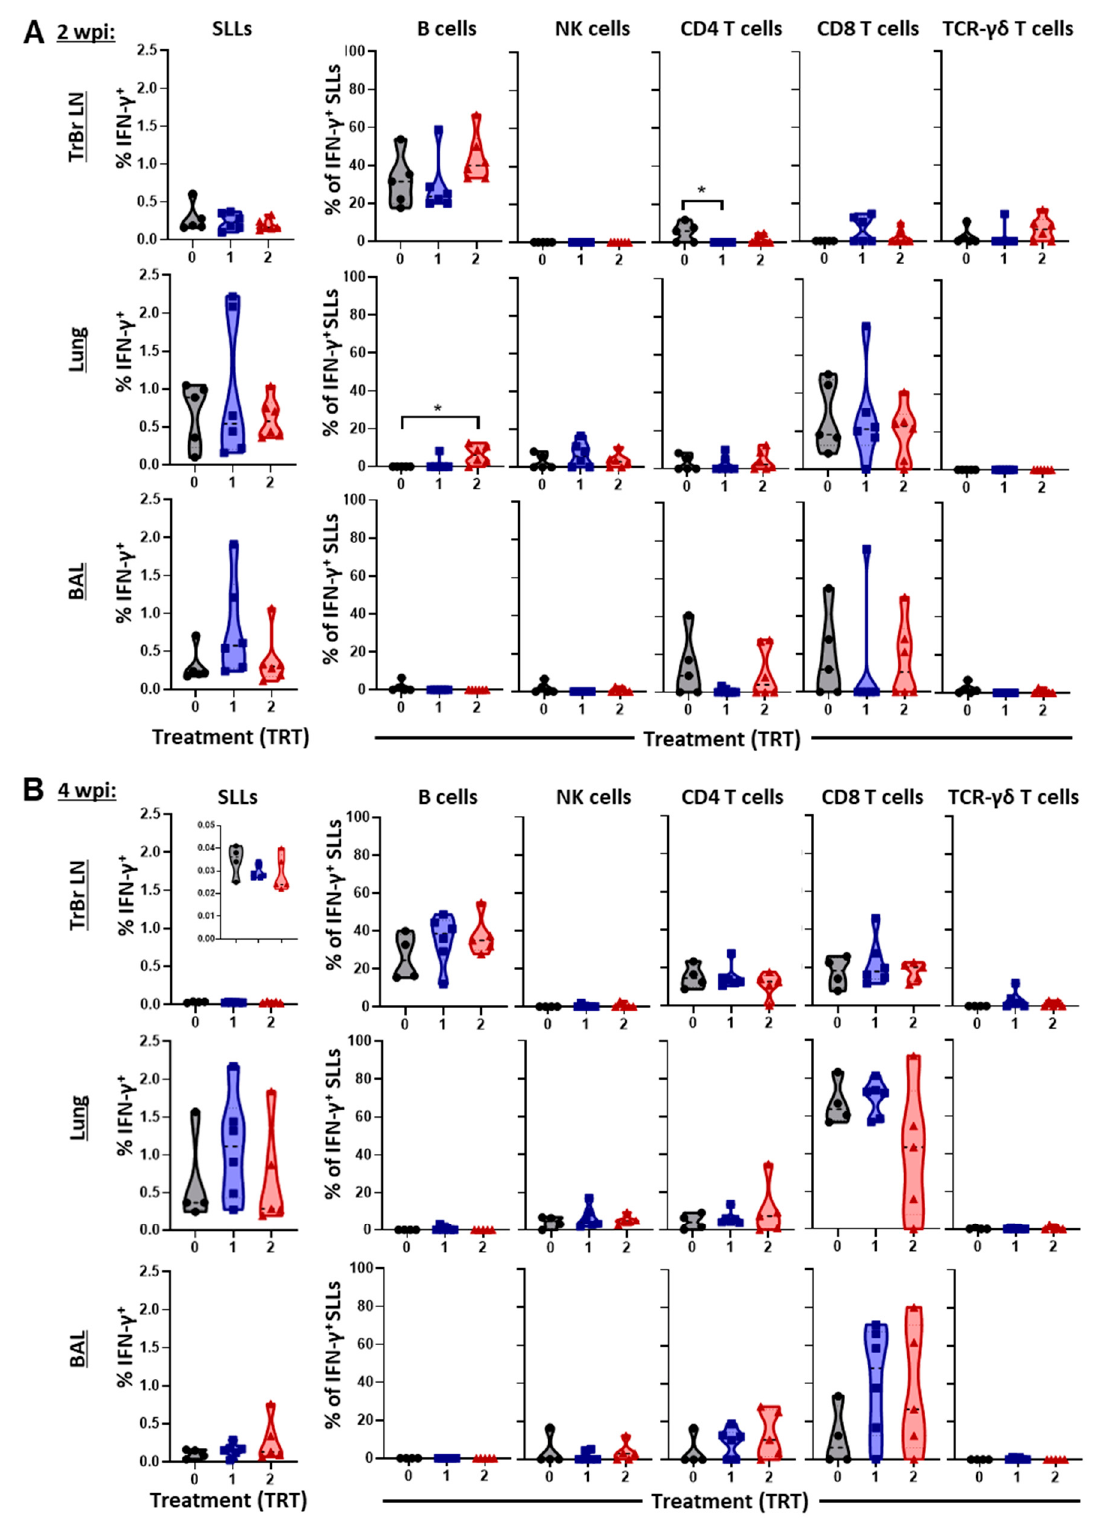
Figure 6. The local IFN- γ response to PRRSV 1-7-4 in bronchoalveolar lavage, lungs, and tracheobronchial lymph nodes of piglets. IFN- γ production as a percentage of all SLLs (left column) and the percentage of each immune cell subsets contributing to this IFN- γ production (all other columns) is shown within tracheobronchial lymph nodes (TrBr LN), lung tissue, and bronchoalveolar lavage (BAL) at 2 wpi ( A ) and 4 wpi ( B ). Data were analyzed via one-way ANOVA with Dunnett’s multiple comparisons. Significant differences between treatments are designated as * p < 0.05.